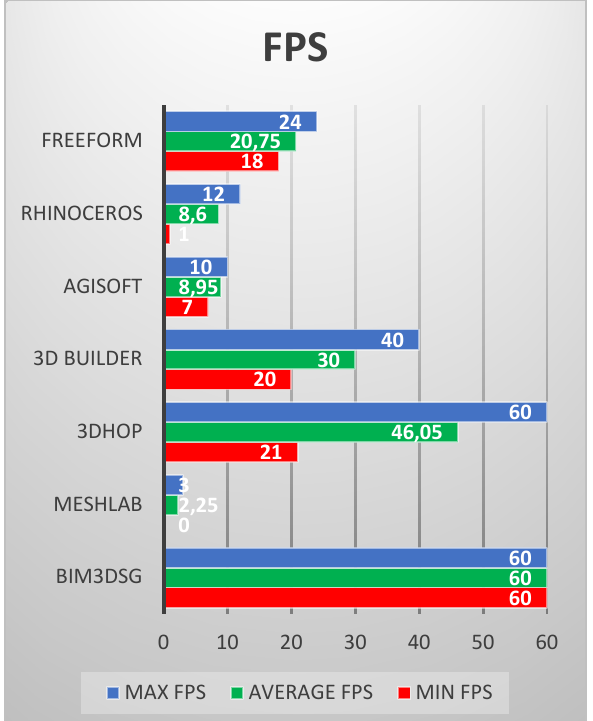
Figure 11: FPS of Umm al-Dabadib’s Forte; monitor locked at 60 FPS, higher is better